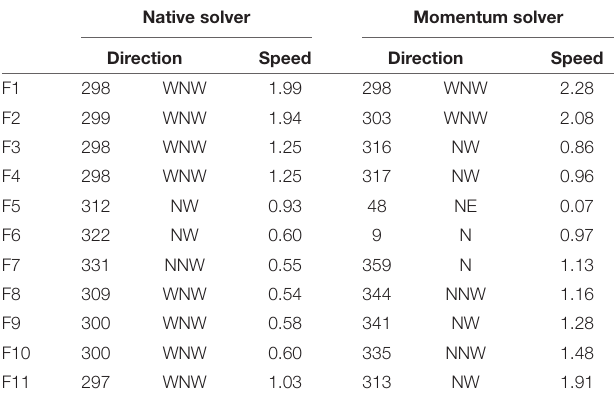
TABLE 3 | Wind direction ( ◦ , compass point) and wind speed (ms − 1 ) predictions using WindNinja with native solver and momentum solver for each site across Flea Creek